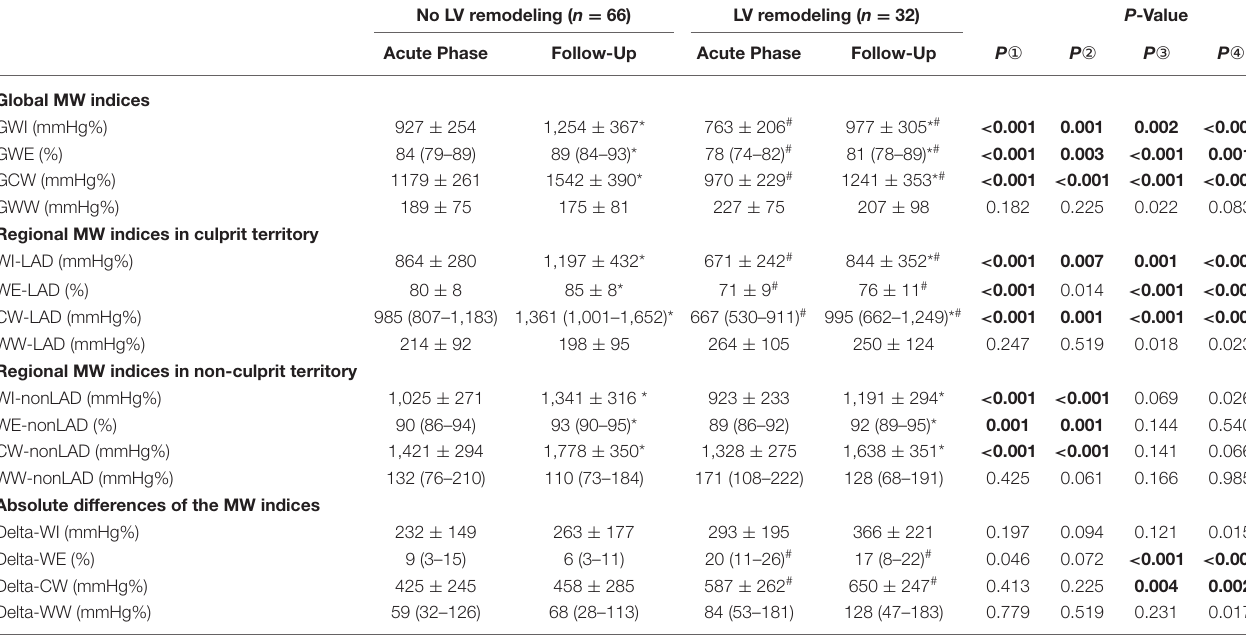
TABLE 3 | Comparison of MW between two groups at acute phase and follow-up.